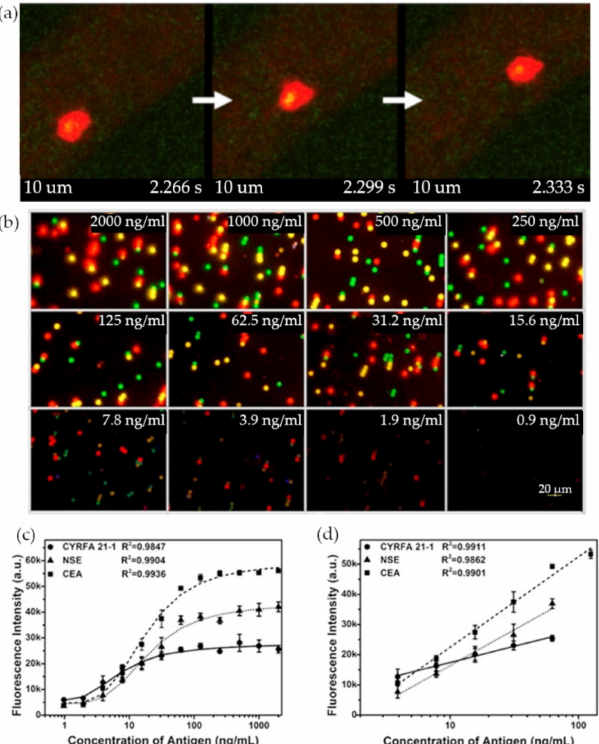
Figure 2. Quantum dots (QDs)-based fluorescence assays: ( a ) Three consecutive images (33 ms interval) of CD133+ circulating tumor cells (CTCs) tagged with red QDs moving in a blood vessel. ( b ) Multiplexed fluorescence of cytokeratin 19 (CYRFA 21-1), neuron-specific enolase (NSE), and carcinoembryonic antigen (CEA) at different concentrations. ( c ) Standard curves for the detection of CYRFA 21-1, NSE, and CEA in the multiplexed assay. ( d ) Linear range of the plot in ( c ). (Reproduced with permission from [20], published by Springer Nature 2019; reproduced with permission from [23], published by Elsevier